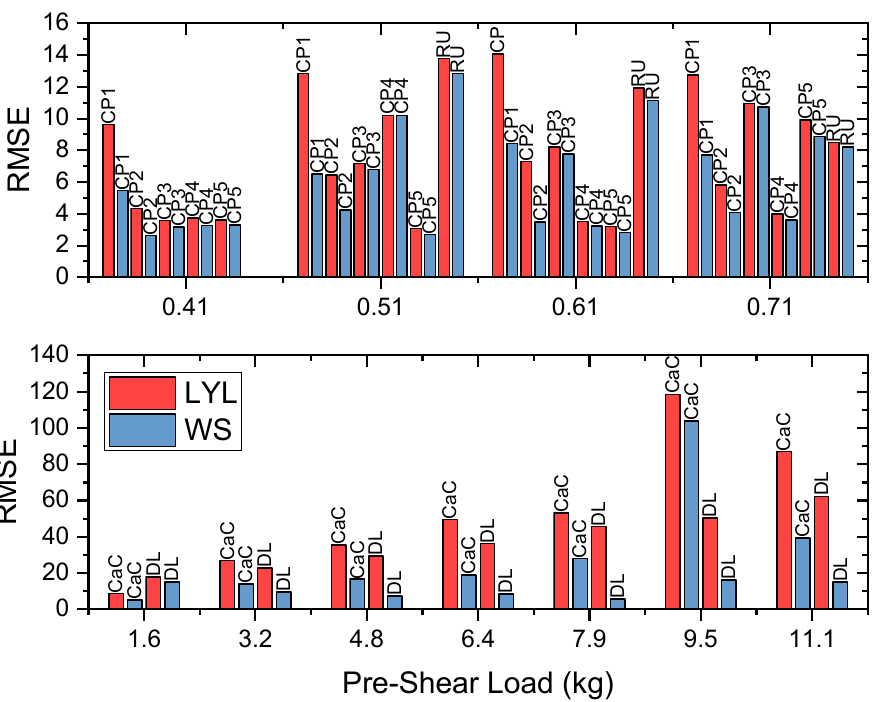
Figure 10. RMSE values for the investigated samples related to the pre ‐ shear loads.